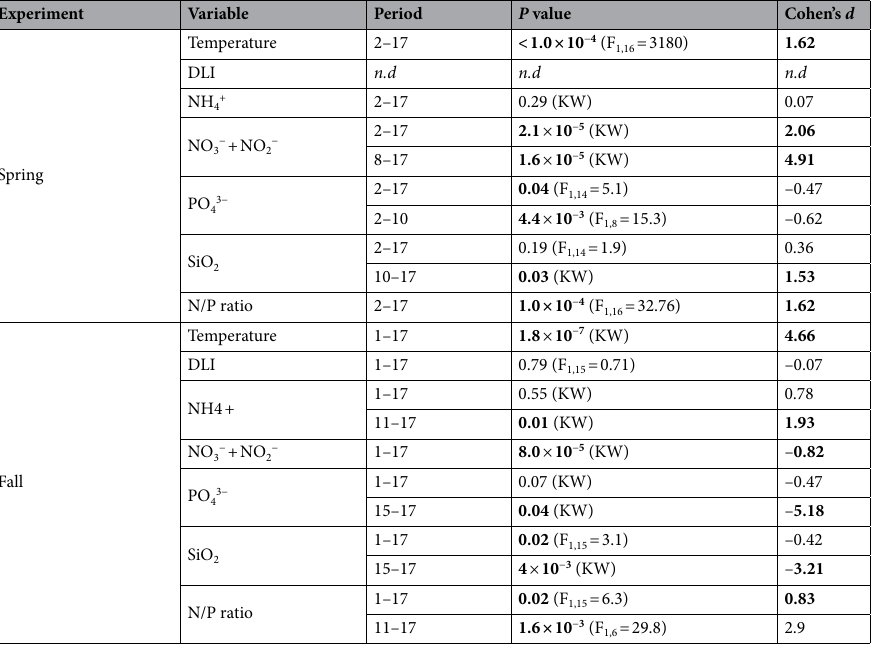
Table 1. Summary of the p values obtained by Repeated Measures Analyses Of VAriance (RM-ANOVA, with treatment as fixed factor and time as random factor) comparing physical parameters and nutrient concentrations in the warmed and control mesocosms. A Kruskal–Wallis test, indicated by “KW”, was used when the assumptions for a parametric test were not met, despite transforming the data. P < 0.05 was considered statistically significant (values indicated in bold). Large and very large Cohen’s d effect sizes are also indicated in bold. Tests were performed from d2 of the spring experiment, when warming reached + 3 °C. ( n.d . not determined, DLI Daily Light